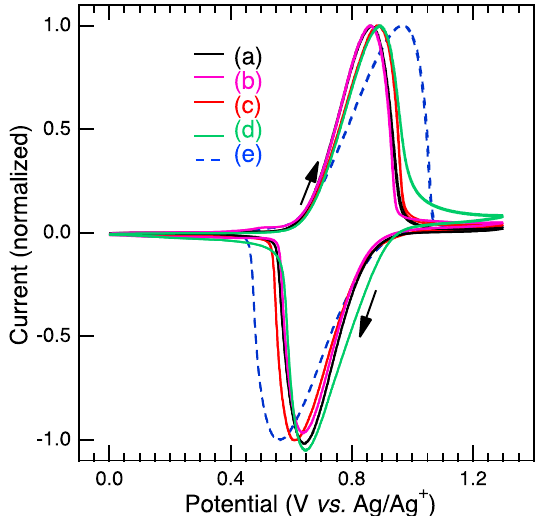
Figure 4. CV curves of polyFe/LIIm composites ( a ) 3/0.1, ( b ) 3/0.5, ( c ) 3/1, and ( d ) 3/5 and ( e ) reference polyFe films cast on ITO glass in a three-electrode system with a spring-type Pt wire as a counter electrode and Ag/Ag + as a reference electrode in 0.1 M LiClO 4 of anhydrous acetonitrile solution as an electrolyte solution with a scan rate of 50 mV/s. Peak currents within the vertical axis normalize these CV curves.